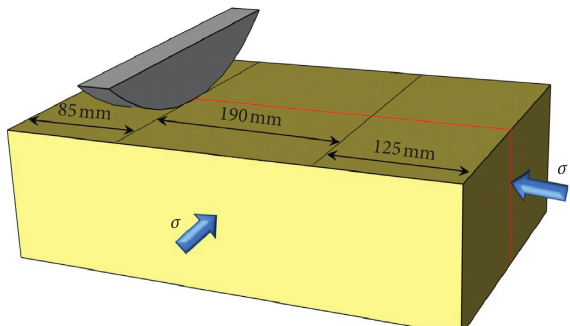
Figure 6: Schematic representation for the positioning of the indentation